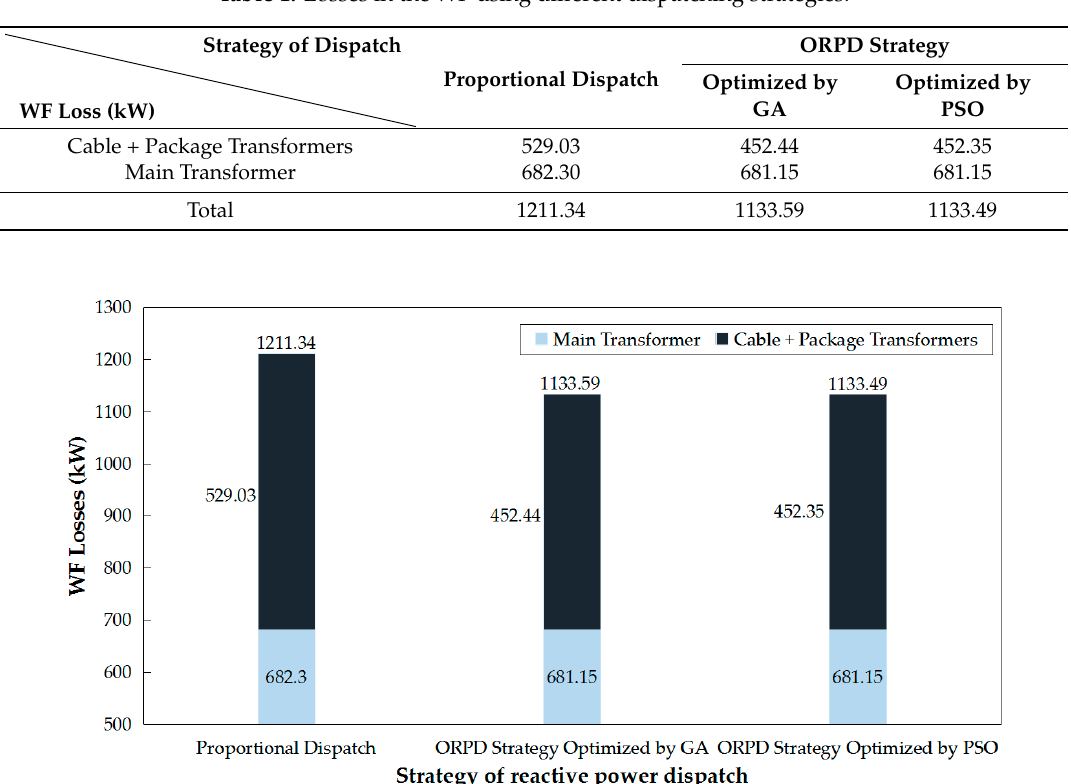
Figure 11. Losses in the WF using different dispatch strategies.